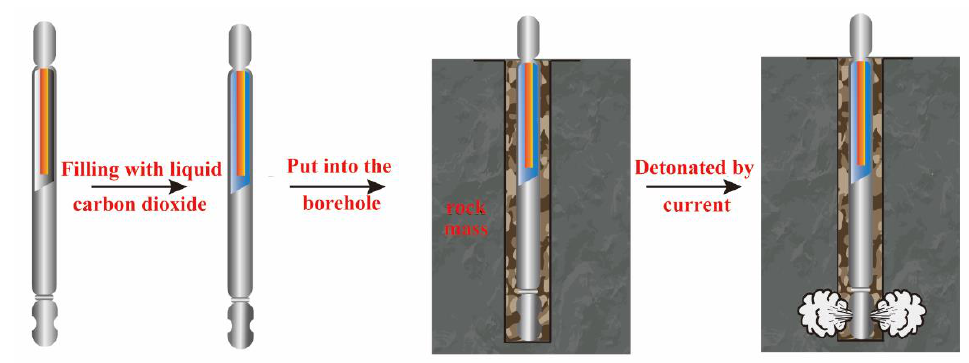
Figure 3. Procedure of carbon dioxide phase transition fracturing.